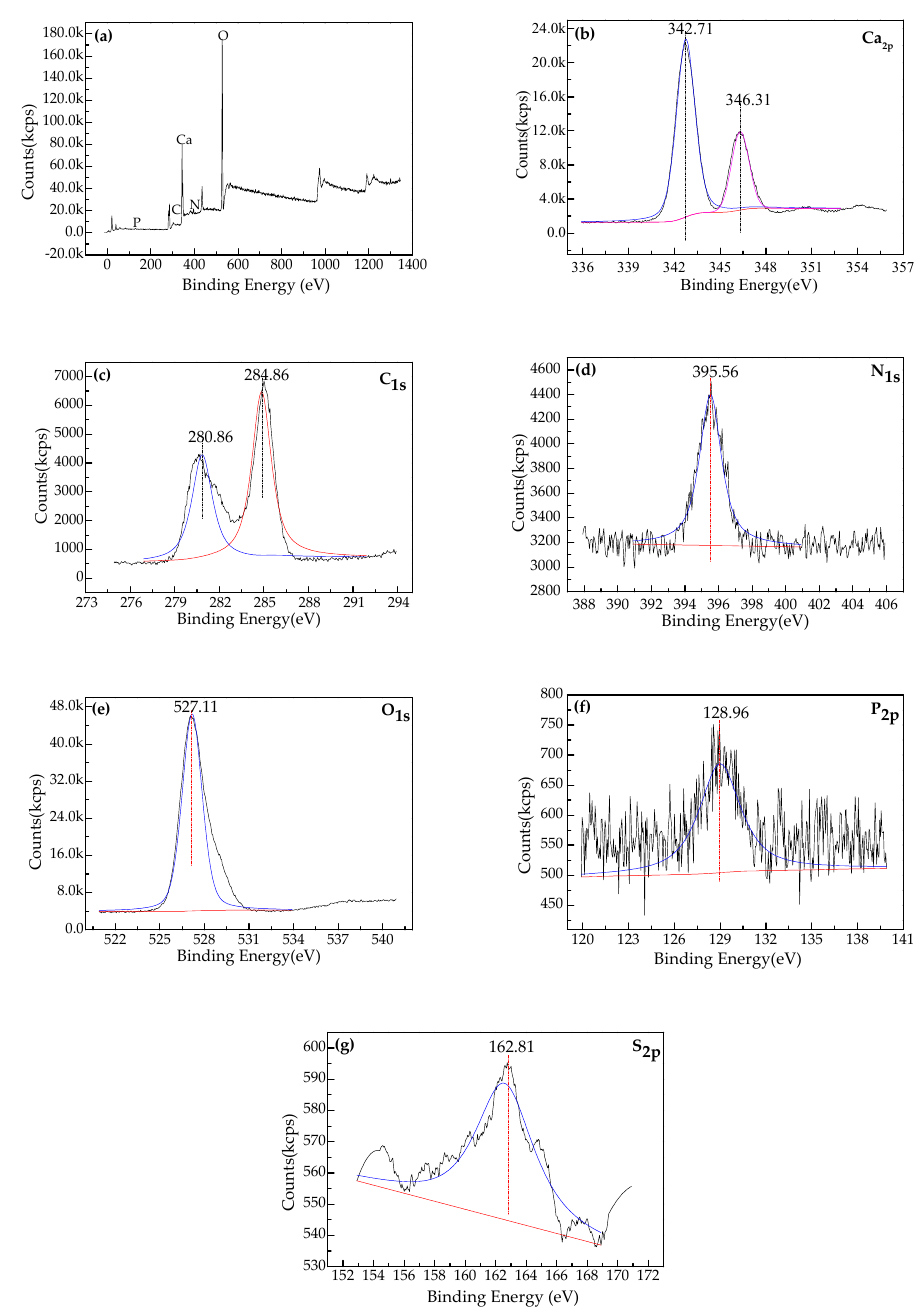
Figure 9. X-ray photoelectron spectroscopy (XPS) broad survey of minerals at Mg / Ca molar ratio of 9 ( a ) and high-resolution of Ca ( b ), C ( c ), N ( d ), O ( e ), P ( f ), and S ( g ).